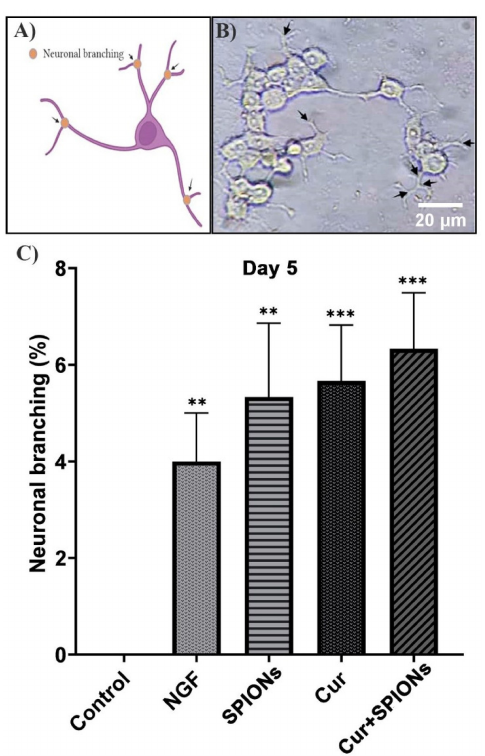
Figure 7. Evaluation of neuronal branching in differentiated PC12 cells. ( A ) Schematic image of assessment of neuronal branching. ( B ) Neuronal branching image in differentiated PC12 cells at 5 days after treatment with Cur+SPIONs and arrowhead indicates the site of neuronal branching in neurite-bearing cells. ( C ) Effects of NGF (50 ng/mL), SPIONs (20 µ g/mL), curcumin (20 µ M), and Cur+SPIONs on neuronal branching at 5 days after exposure to differentiation conditions at and the concentration of Cur was 20 µ M in each combination Cur+SPIONs, and the concentration of SPIONs was also 20 µ g/mL (** p < 0.01 and *** p <